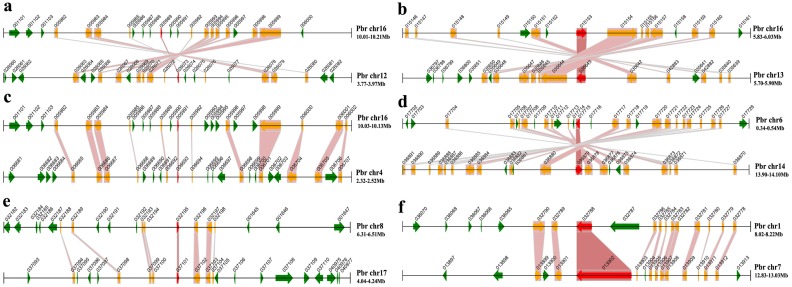
Segmental duplication of the MADS-box family in pear.A region of 100 kb flanking each side of the MADS gene is displayed. The black horizontal line denotes a chromosome segment with the chromosome name and region on the right, and the gene and its transcription orientation is indicated by a broad line with an arrowhead. The text beside the line is the gene name suffix. The MADS genes are shown in red, homologous genes in yellow, and other genes in green. Homologous gene pairs are linked with red bands. (A) PbrMADS95 (Pbr005989.1) and PbrMADS93 (Pbr026073.1) (B) PbrMADS2 (Pbr015153.1) and PbrMADS1 (Pbr035643.1) (C) PbrMADS92 (Pbr005991.1) and PbrMADS91 (Pbr006693.1) (D) PbrMADS16 (Pbr017715.1) and PbrMADS14 (Pbr036879.1) (E) PbrMADS75 (Pbr032195.1) and PbrMADS74 (Pbr037101.1) (F) PbrMADS23 (Pbr032788.1) and PbrMADS22 (Pbr013902.1).